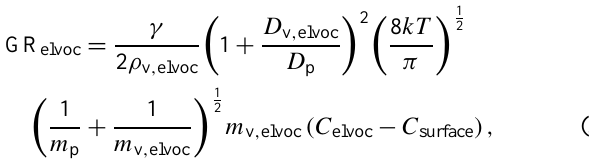
Kelvin curve -pure organic droplet Kelvin curve -binary solution with a fixed organic fraction C surface for D p > D p,act (nano-Köhler curve) C surface for D p < D p,act